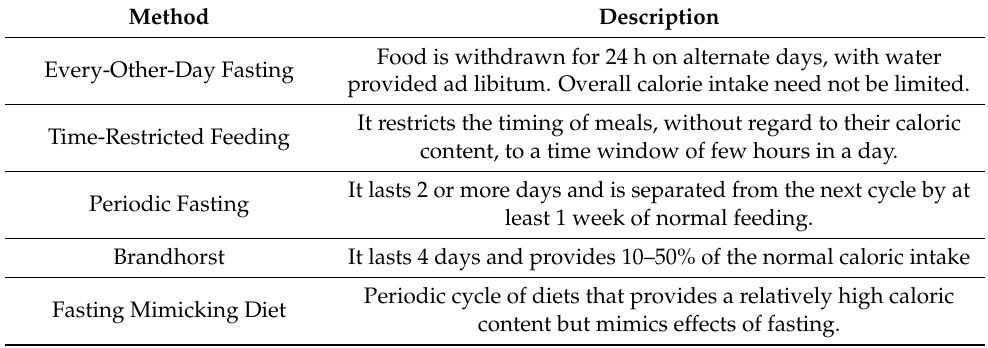
Table 2. Proposed methods for